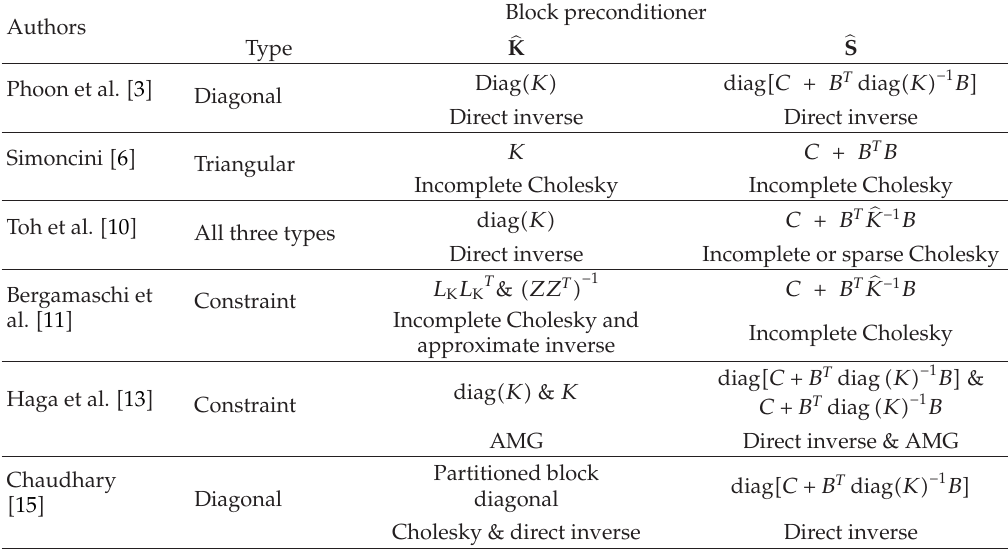
Table 1: Block preconditioners recently proposed for Biot’s linear